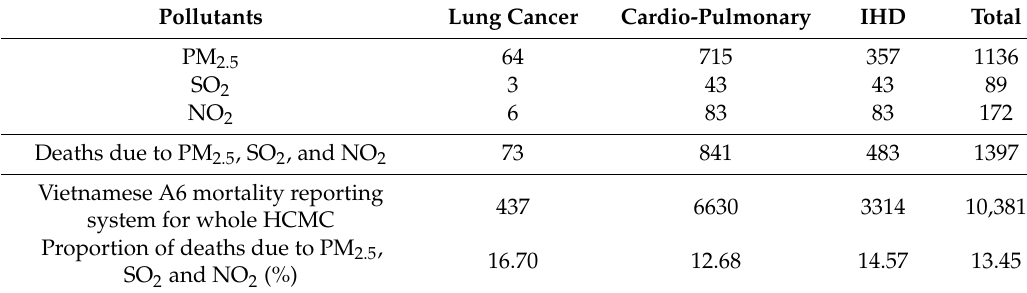
Table 7. Mortality burden from air pollution in HCMC (Unit: Death